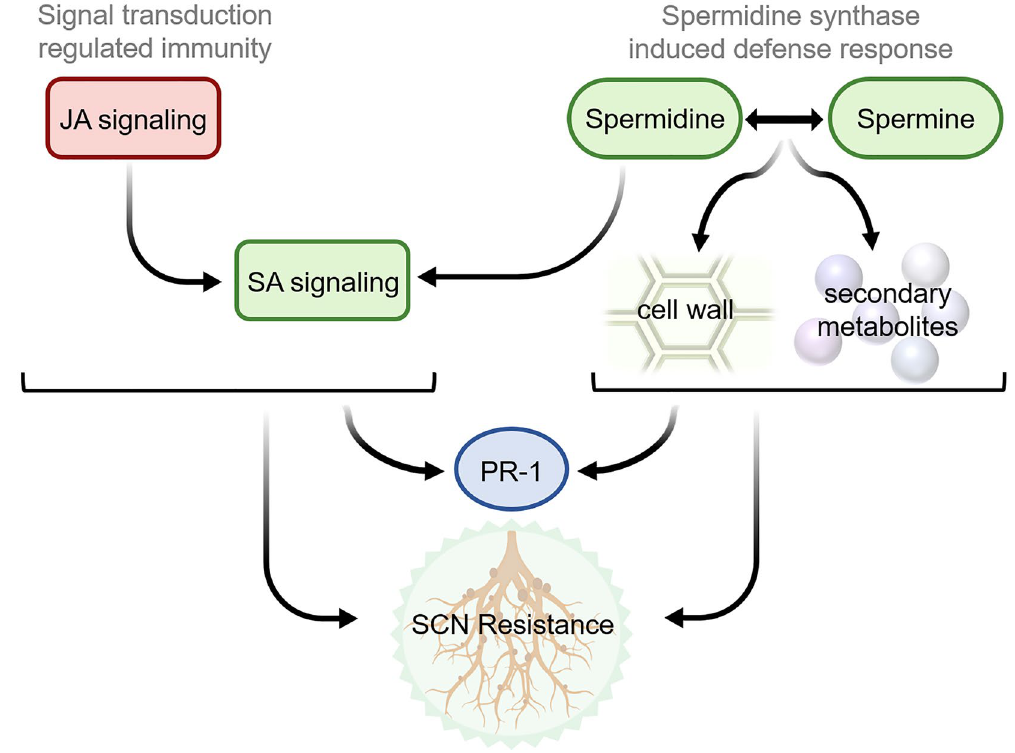
Figure 4. Pathway of resistance in NRS100 includes upregulation of SA signaling by JA suppression, induced PR-1 genes, accumulation of polayamines (spermidine and spermine), reinforcement of the cell wall, and production of secondary